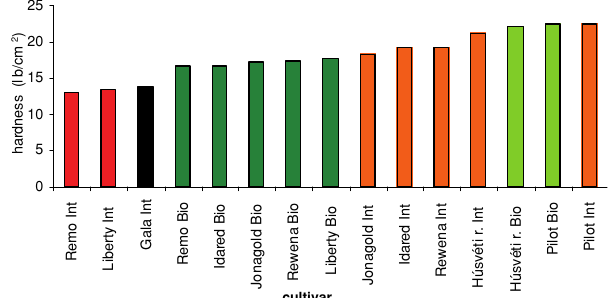
Figure 4. Range of varieties according to firmness measured (Debrecen, 2008)